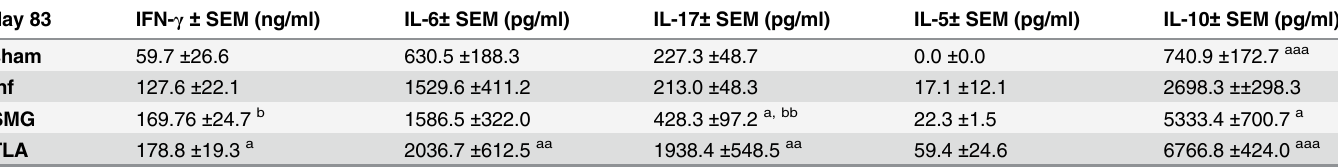
Table 1. Cytokine production of splenocytes stimulated with TLA in vitro .